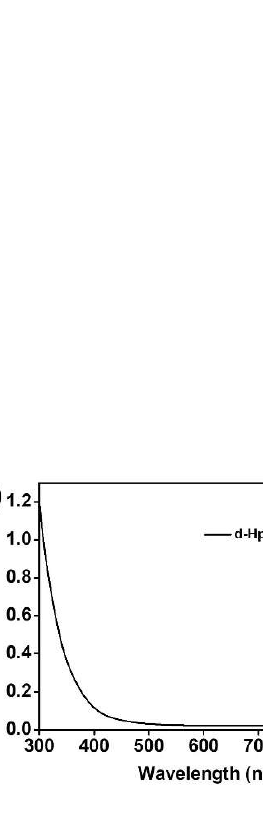
Figure 2. ( a ) UV-Vis absorption spectrum of the derived haptoglobin peptide-conjugated gold nanoclusters (d-Hp-AuNCs), ( b ) XPS spectra of d-Hp-AuNCs (black line), simulated spectrum of Au 4 F 7/2 (red line), and simulated spectrum of Au 4 F 5/2 (blue line). ( c ) Fluorescence spectrum of the derived Hp peptide (black line) and d-Hp-AuNCs (red line).